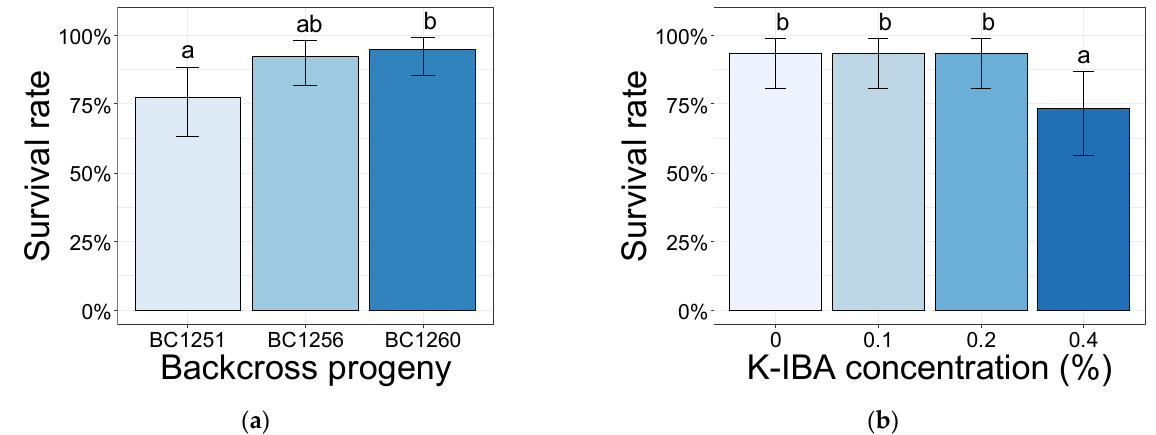
Figure 1. Survival rate (%) of the cuttings obtained from the peach backcross progenies BC1251, BC1256, and BC1260 ( a ), and the K-IBA concentration treatments applied at 0.0%, 0.1%, 0.2%, and 0.4% ( w/v ) ( b ). Data were calculated after 35 days of rooting. Bars bearing the different letters are significantly different at p ≤ 0.05.